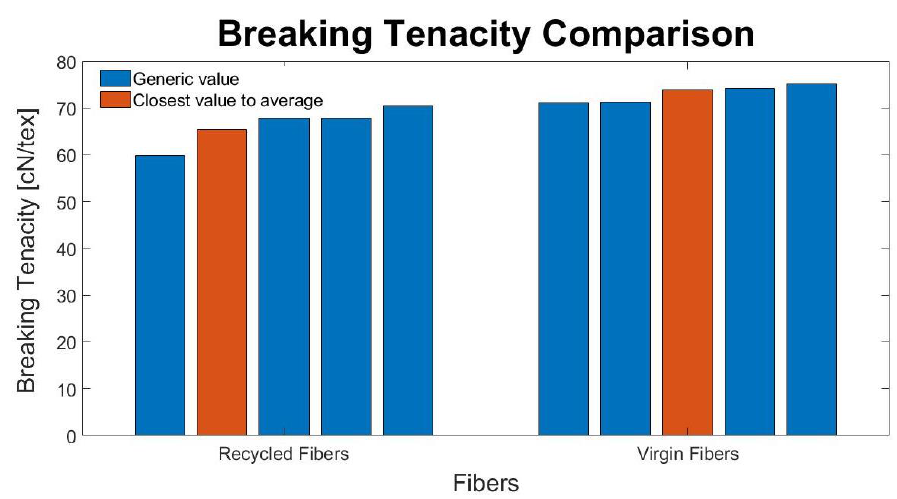
Figure 9. Breaking tenacity comparison between virgin and recycled